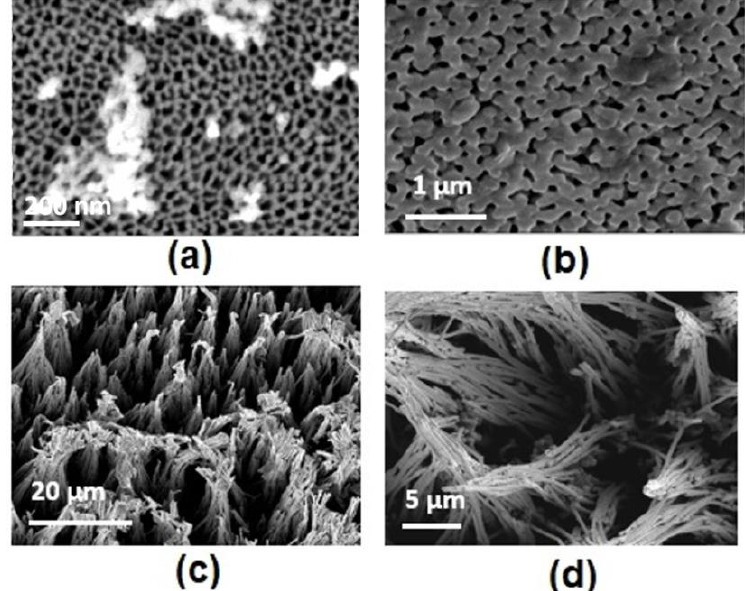
Figure 6. FESEM micrograph of highly ordered nanorods at potential of − 1.1 V ( a ) top view of the AAO template, ( b ) Another top view of un-even deposits of nanostructures, ( c ) cross-section of the AAO template showing dense array of nanorods, and ( d ) a higher resolution image of the ( c ).